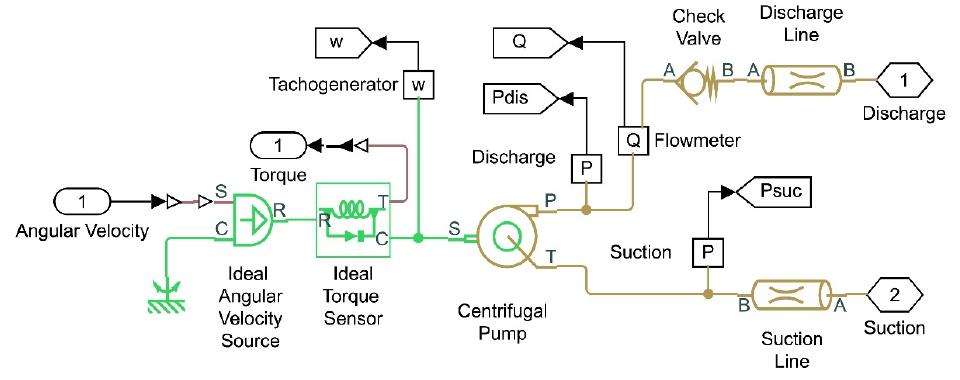
Figure 5. Pump train model developed in Simulink.